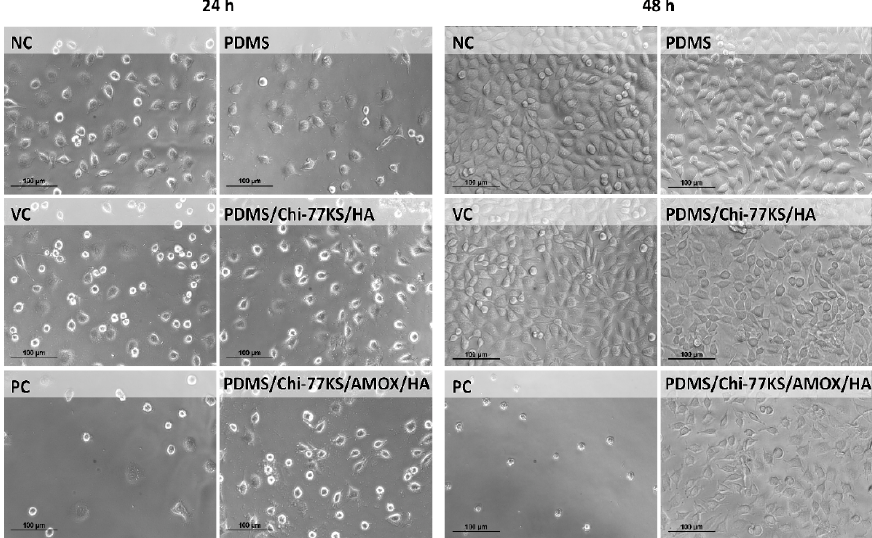
Figure 13. Morphology of L929 cells after 24 ± 1 and 48 ± 1 h of exposure to the PDMS disc extracts (100 V / V % corresponding to 1.25 cm 2 /mL, respectively). NC—negative control, fresh growth media; VC—growth medium, incubated under extraction conditions; PC—positive control, etoposide (100 μ g/mL). Micrographs were taken under a light microscope (phase contrast) at 10 × 20 times magni- fication.